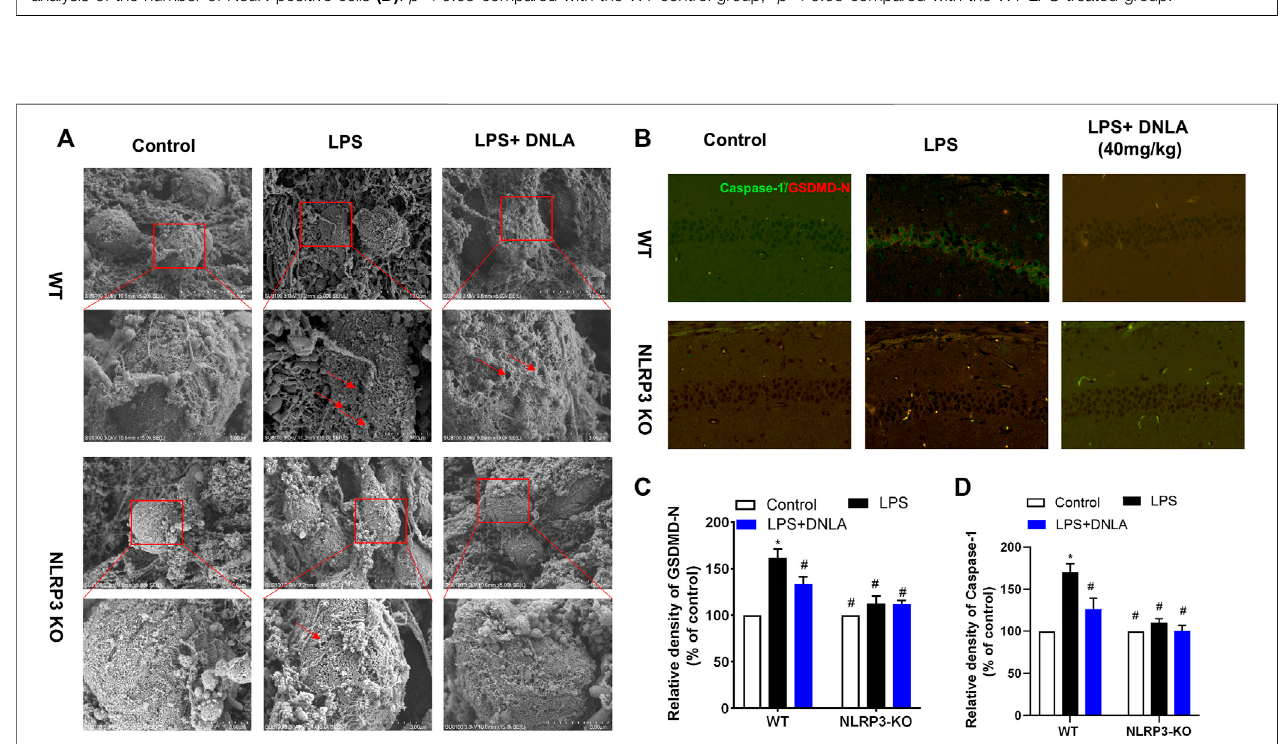
FIGURE 6 | NLRP3 signaling participated in DNLA-mediated neuroprotection. WT mice and NLRP3-KO mice were given DNLA (40 mg/kg) intragastrically for 14 consecutive days. On the seventh day after DNLA treatment, mice received a single intranigral injection of LPS (2 μ g) on both sides of the hippocampus. After DNLA treatment for 10 days, the novel object recognition test (A) and Y-maze test (B) were determined. The neuronal number in hippocampus CA1 was measured by immuno fl uorescence staining;the redcolor indicatedNeuN-positive cells, and theblue represented theDAPI-stained nucleus. Scalebar =50 μ m (C) .Quantitative analysis of the number of NeuN-positive cells (D) .* p < 0.05 compared with the WT control group; # p < 0.05 compared with the WT LPS-treated group.